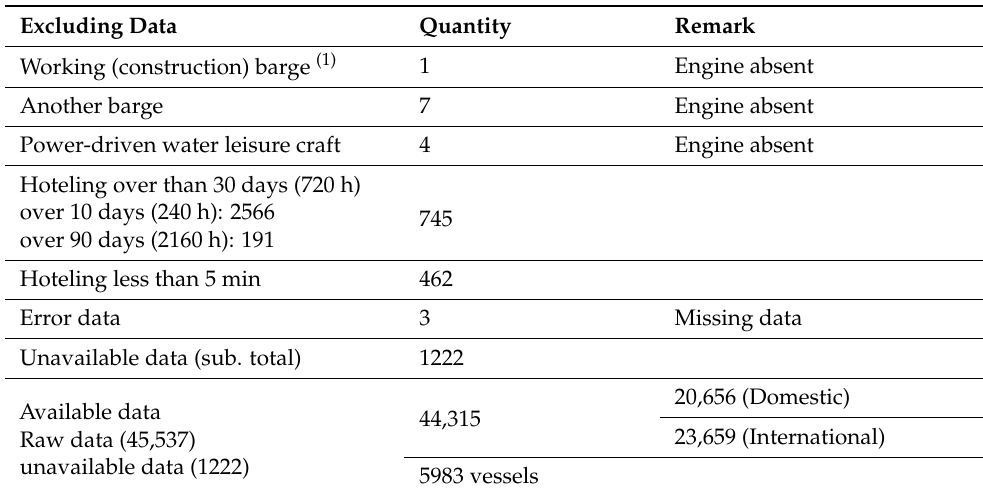
Figure 3. Classification of ship type. Figure 3. Classi fi cation of ship type. Table 2. Raw data